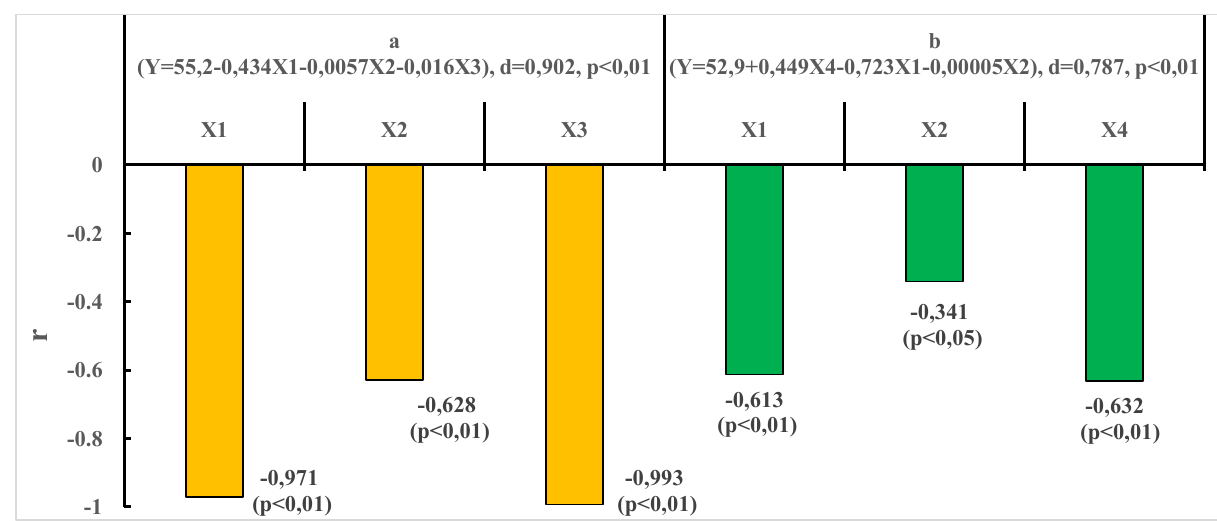
Fig.1. Coefficients of correlations and regression models reflecting association between accuracy of target shooting and posture somatic parameters, recorded during ready position (a) and just before the shot (b): r – coefficients of correlation; Y – result of shooting, points; X1 – tremor amplitude, mm; X2 – EMG of DM, mkV; X3 – EMG of BRM, mkV; X4 – amplitude of sagittal stabilogram,